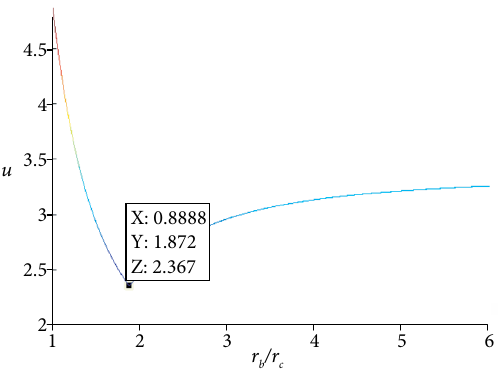
Figure 12. The relationship between the radius ratio of bar to cable r